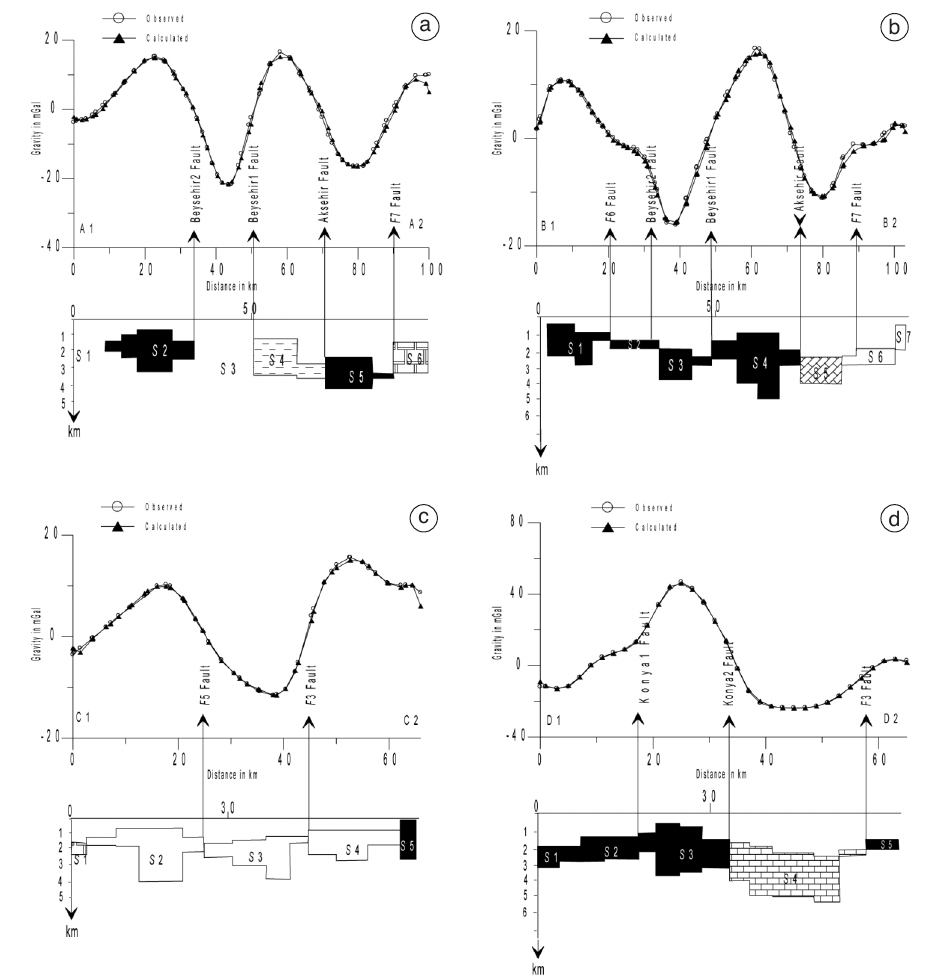
Fig. 9a-d. Anomaly profiles and estimated models. a ) A